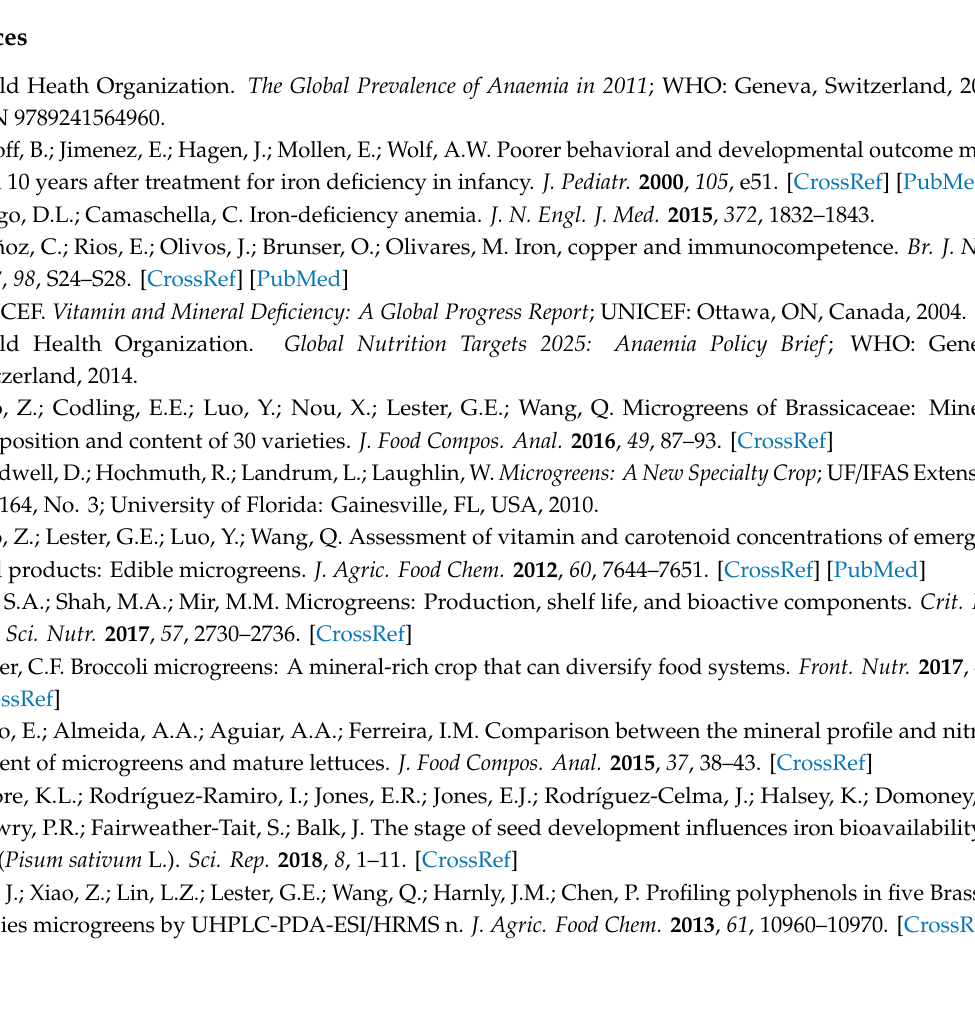
Figure S1: Iron uptake by Caco-2 cells from ferrous sulfate. Samples FeSO4 (50 µ M) iron salts alone with or ascorbic acid (AA) were exposed to cells directly or after in vitro digestion